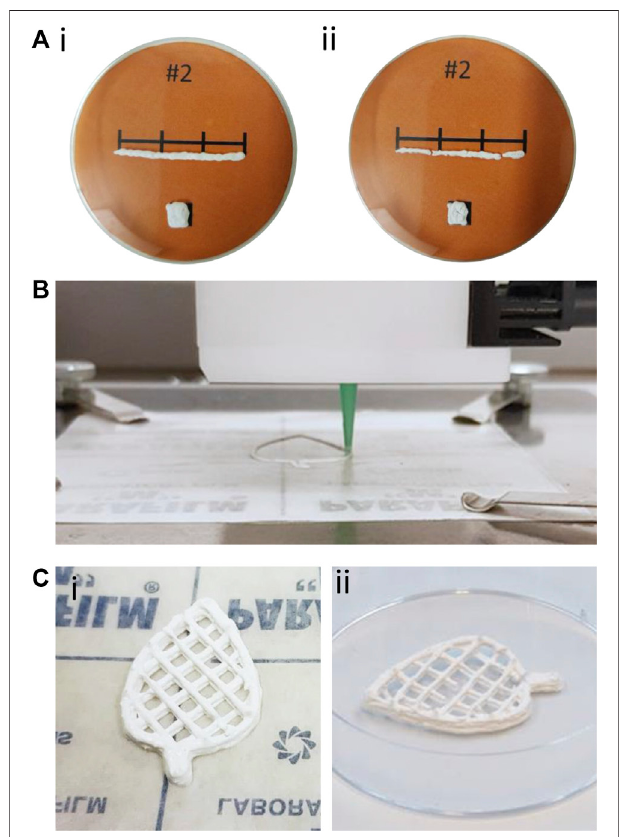
FIGURE 5 | (A) Manually extruded line and square of sample CNF13MC87 (i) before and (ii) after drying. (B) 3D printing of the contour of a leaf. (C) Photographsofthe3Dprintedleafstructure(i)inwetstateand(ii)after drying.